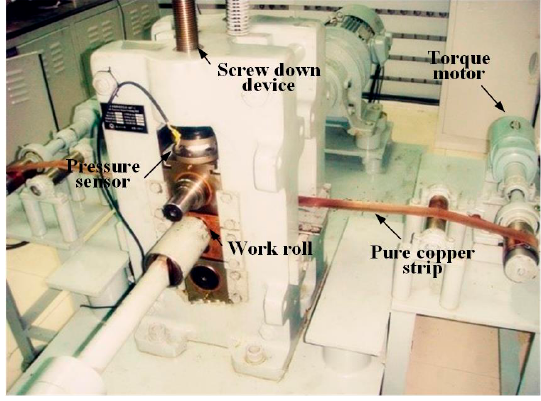
Figure 2. Illustration of 3M mill (micro metal forming mill).